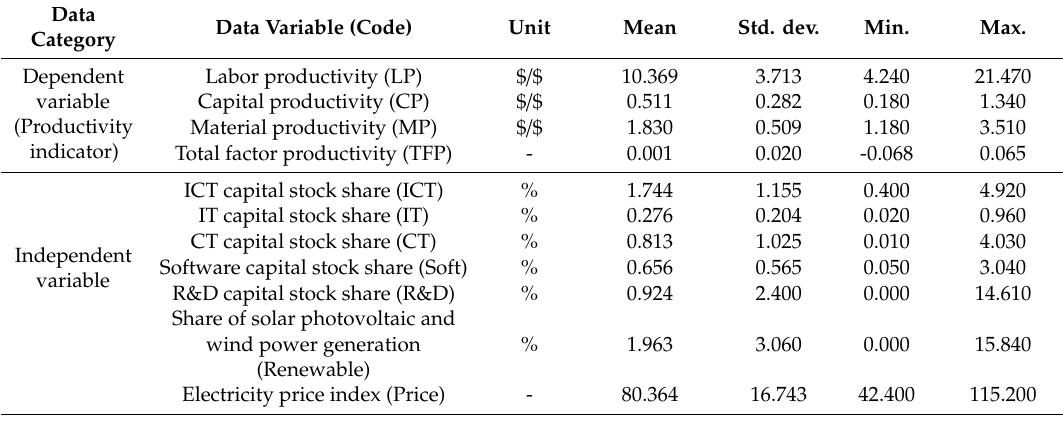
Table 2. The description of data variables for the 2nd step of estimation (determinant